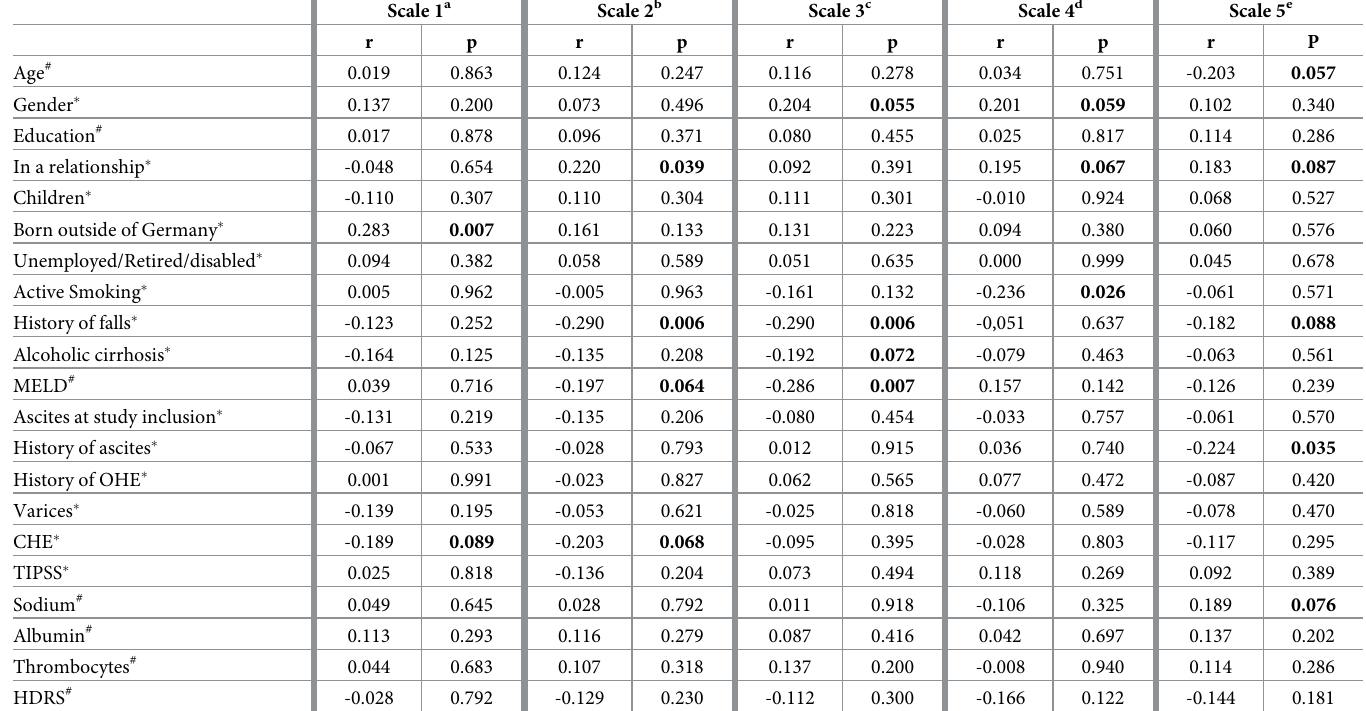
Table 2. Univariable analyses of risk factors of the HLQ subscales